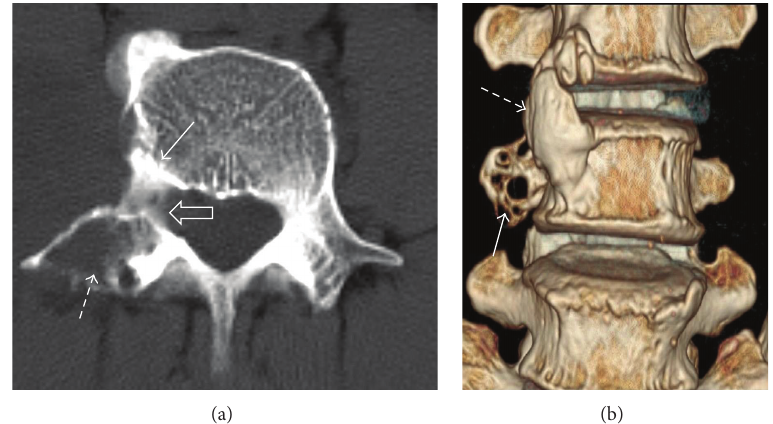
Figure 2: Axial CT image (a) at L4 shows bone erosion (dashed arrow), sclerosis (white arrow), and widening of the exit foramina (open arrow). Volume rendered three-dimensional coronal image (b) demonstrates the focal erosion at the transverse process (white arrow) and anterolateral osseous bridging between the L3 and L4 vertebral bodies (dashed arrow).